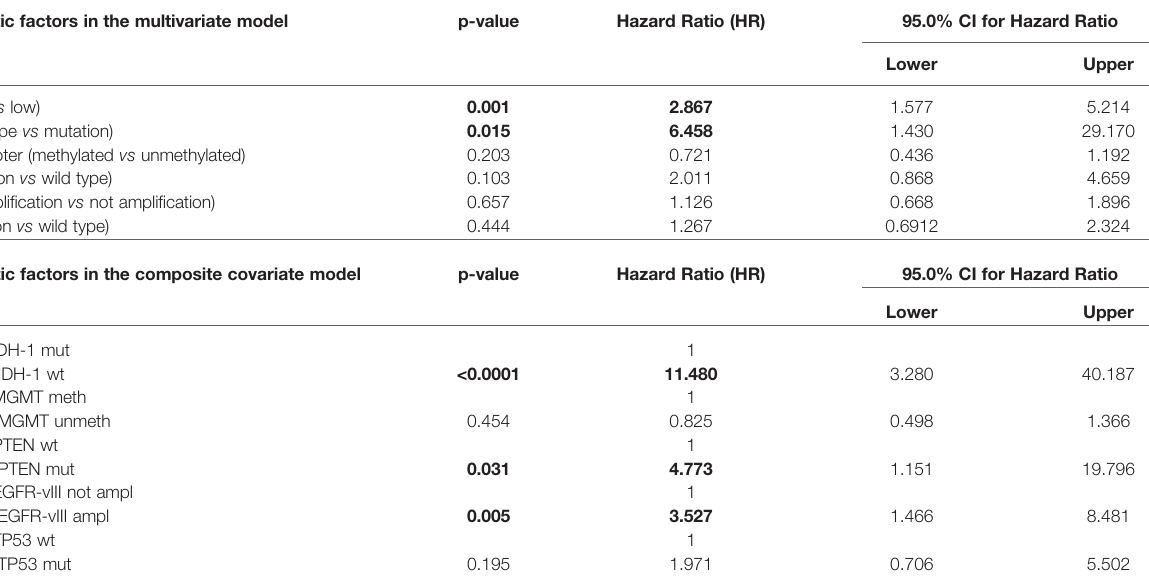
TABLE 1 | (A, B) Multivariate Cox proportional hazards model using Enter and Forward stepwise function including IDH-1, MGMT promoter, EGFRvIII, TP53, PTEN genes. (A) Prognostic factors in the multivariate model